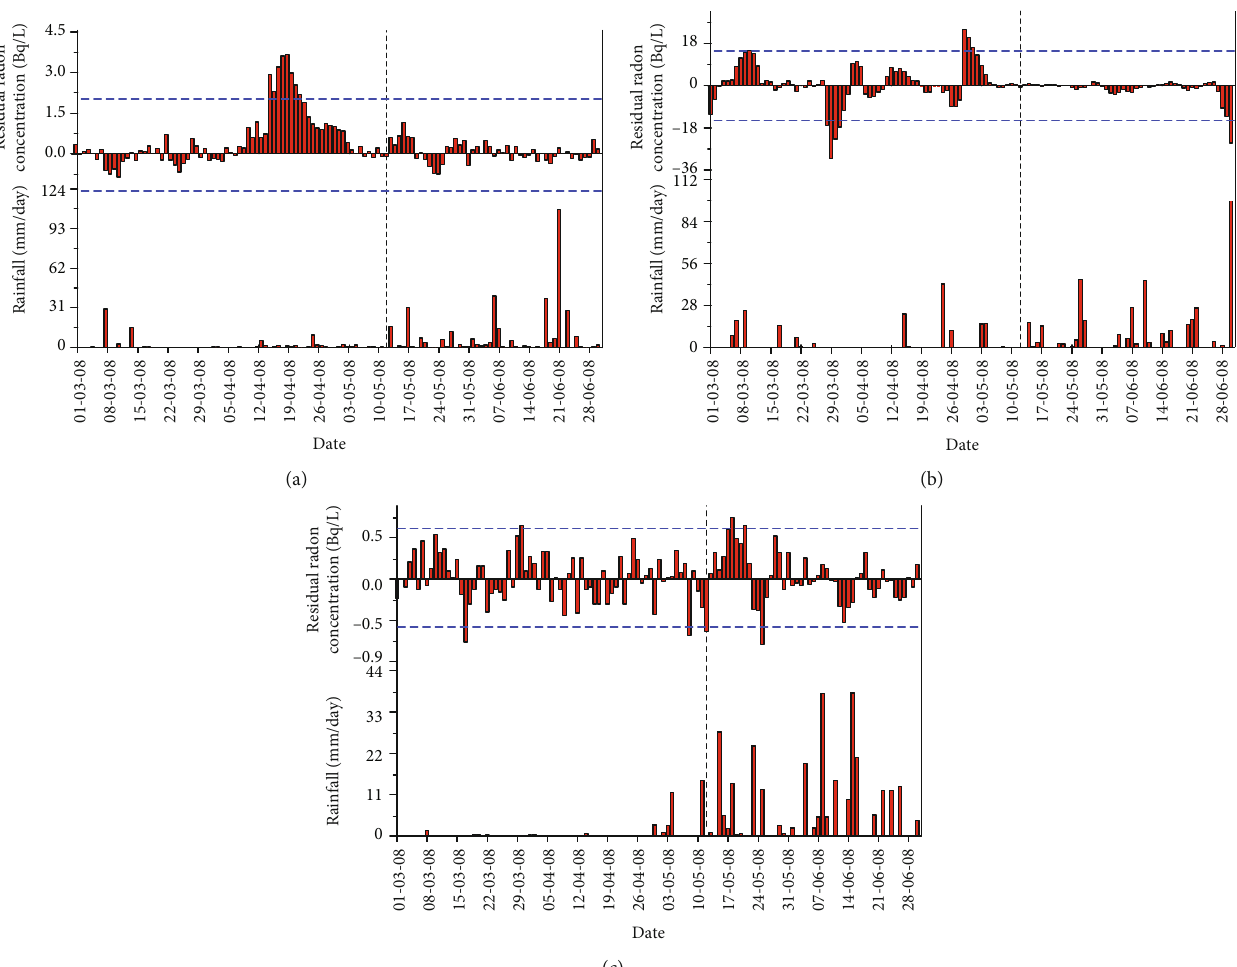
Figure 6: The results of the residual Rn time series for (a) GS, (b) ZJS, and (c) PZHS monitoring stations along with daily precipitation record. The GS monitoring station shows a very prominent possible preearthquake anomaly observed from April 12, 2008, to April 26, 2008. On the contrary, the ZJS and PZHS stations show multiple short-term Rn anomalies both preceding and succeeding this particular event. The black vertical dotted line indicates the time of earthquake